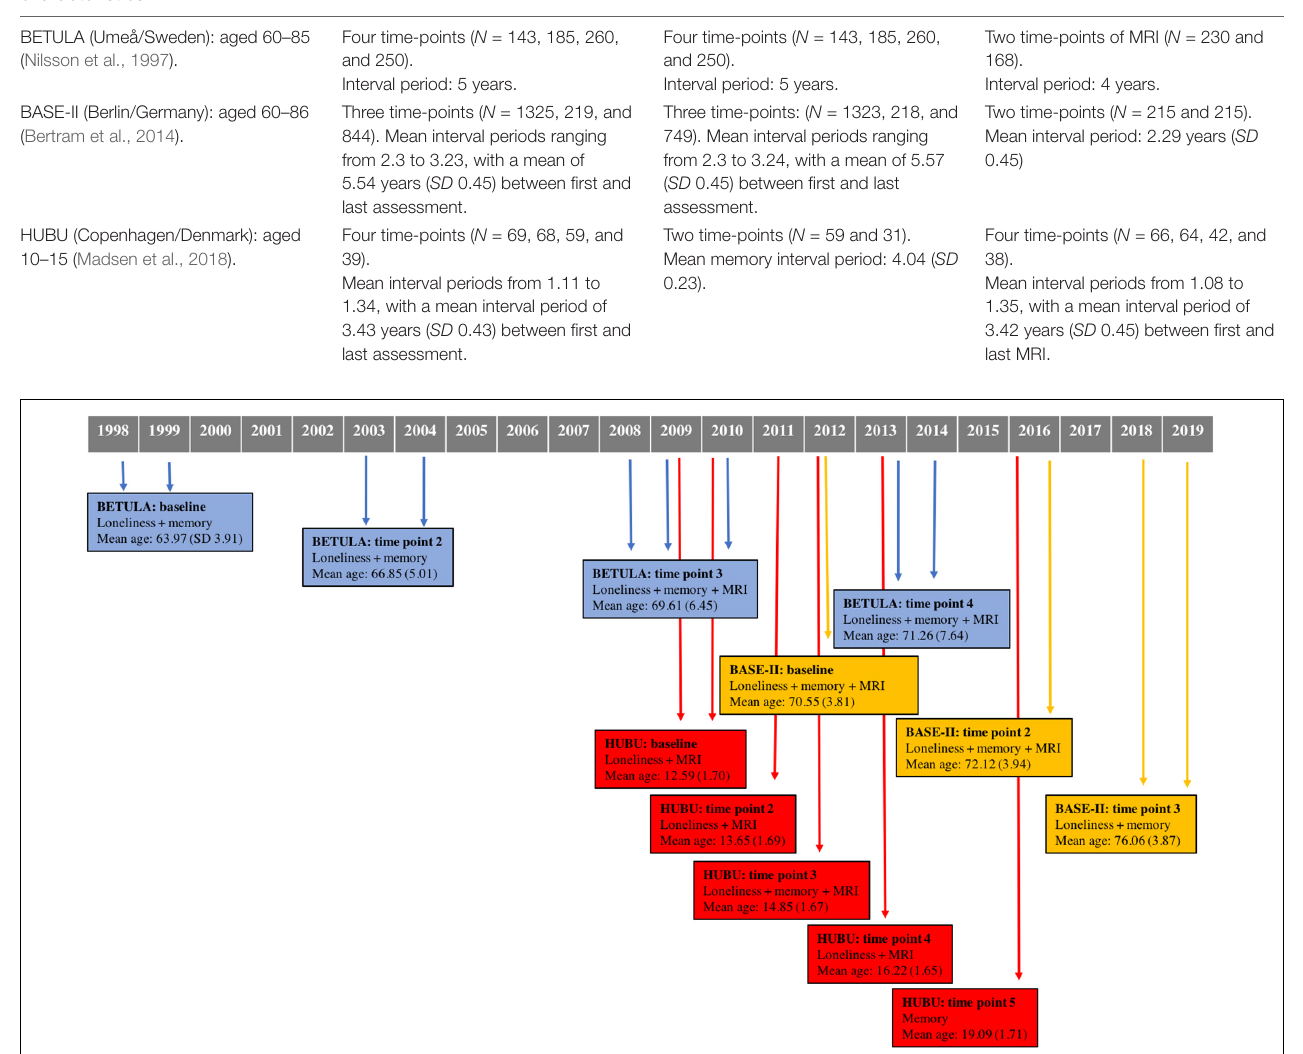
FIGURE 1 | Data collection timeline for each cohort, indicating time of assessment, measures conducted for each time point, as well as mean age and standard deviation. MRI, magnetic resonance